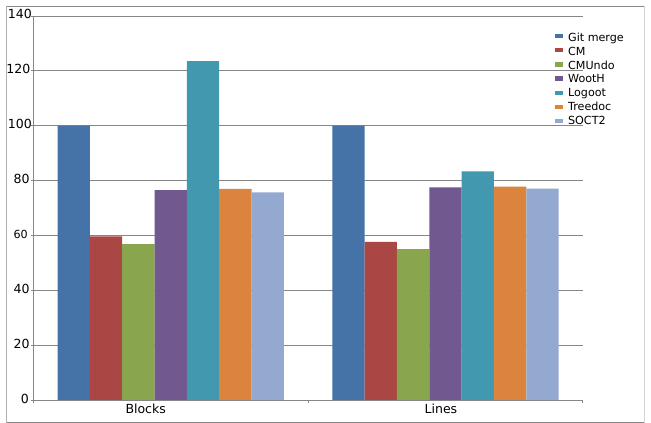
Figure 17. Total merge block and merge